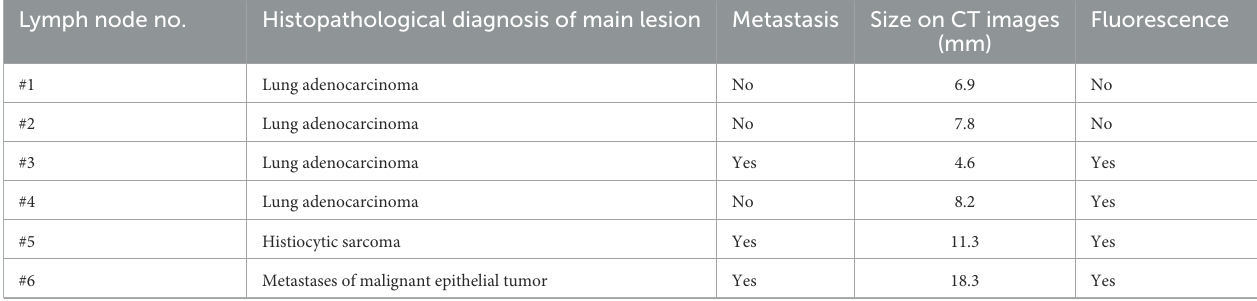
TABLE 3 Size on CT images and fluorescence of tracheobronchial lymph nodes. Lymph node